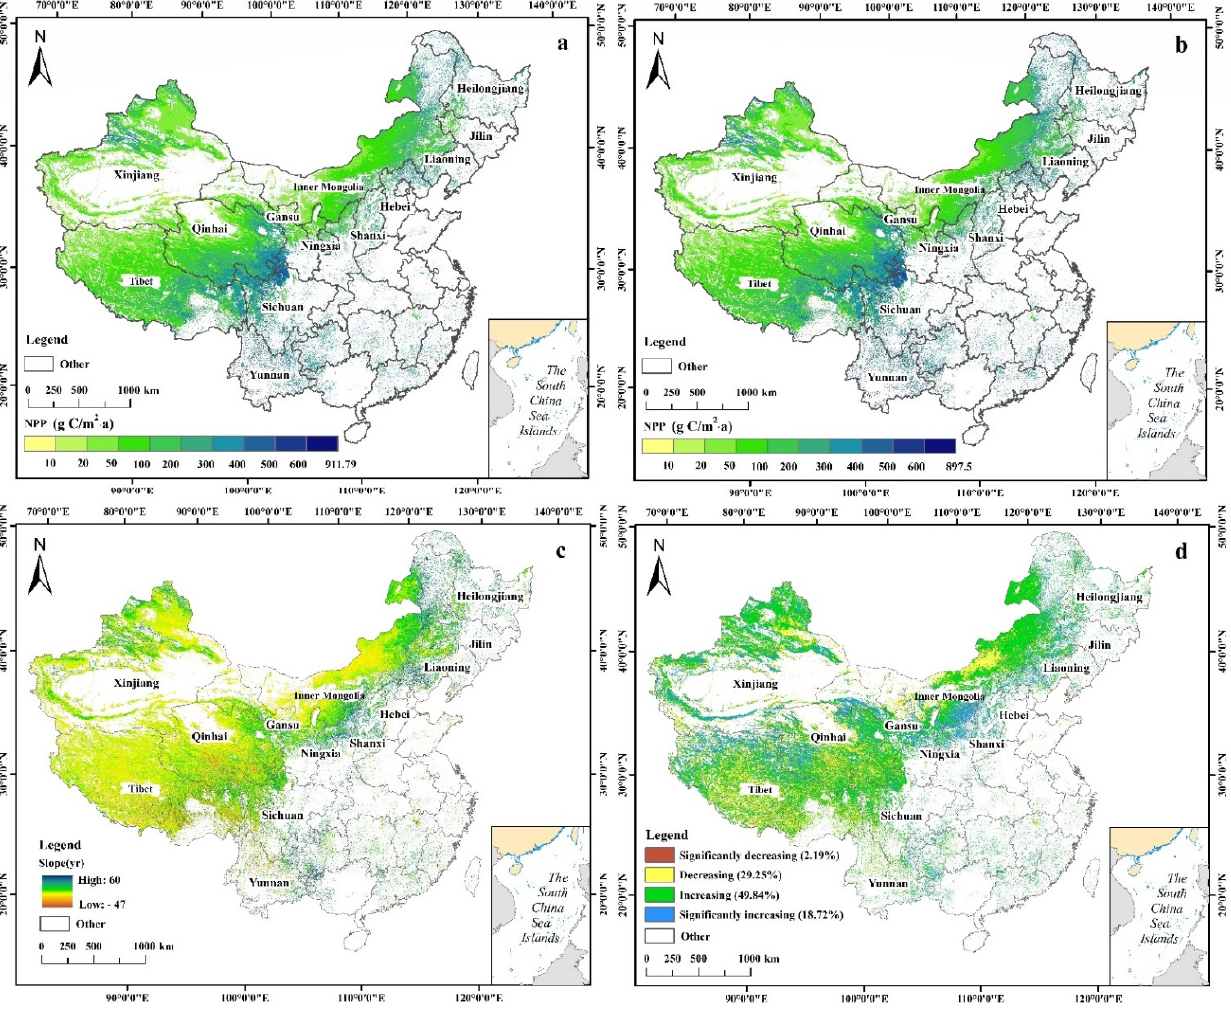
Figure 5. The spatial distribution and trend of the actual grassland NPP in China before (2004–2010) and after (2011–2017) the implementation of the SISGC. The average before the SISGC implementation ( a ); the average after the SISGC implementation ( b ); ( c ) trend change (2004–2017); trend change grading ( d ). Table 1. The statistical description for the average NPP (g C m − 2 a − 1 ) among grassland super-class groups before (2004–2010) and after (2011–2017) the implementation of the SISGC.